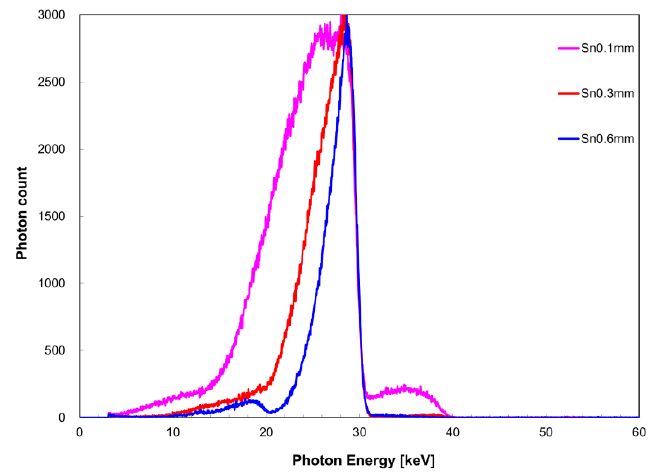
Figure 5. Filter thickness dependence of X-ray spectrum when the tin filter was used.